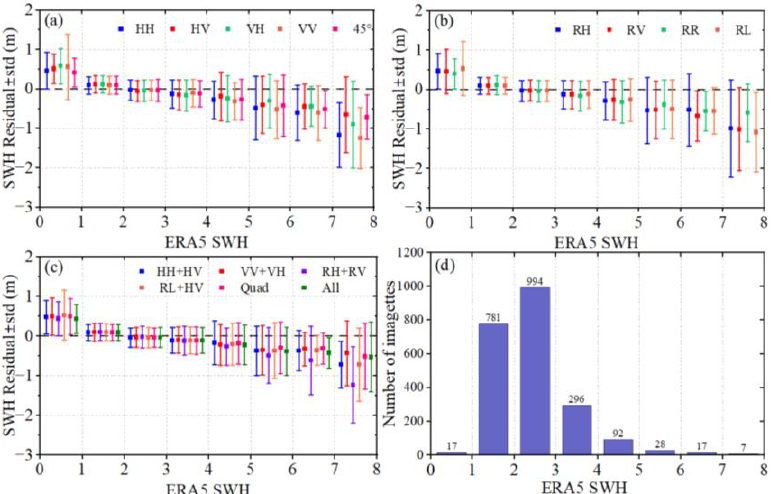
Figure 9. Comparison of SWH residuals against ERA5 SWH, with error bars presenting the standard deviation. The Gaofen-3 SAR SWH estimates were obtained from the XGBoost model under the 15 polarization modes of ( a ) HH, HV, VH, VV, 45°; ( b ) RH, RV, RR, RL; and ( c ) HH + HV, VV + VH, RH + RV, RL + HV, Quad, All. ( d ) Histogram of ERA5 SWH in bin size of 1 m, where the data count is labeled in black text.